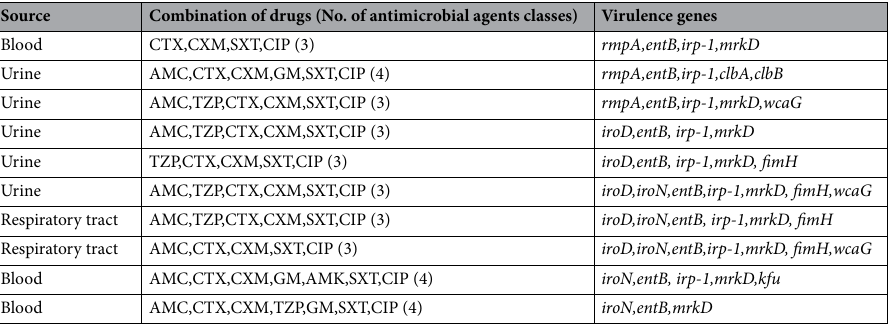
Table 6. Multidrug-resistance of hvKp isolates producing ESBLs. AMC—amoxicillin plus clavulanic acid, TZP—piperacillin plus tazobactam CTX—cefotaxime, CXM—cefuroxime, AMK—amikacin,